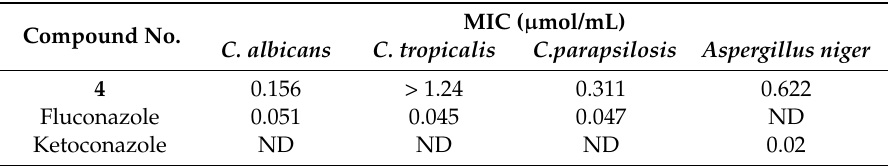
Table 6. The minimum inhibitory concentrations (MICs) values for the antifungal activity of the semicarbazone 4 , fluconazole and ketoconazole towards Aspergillus niger and various Candida species. Compound No.